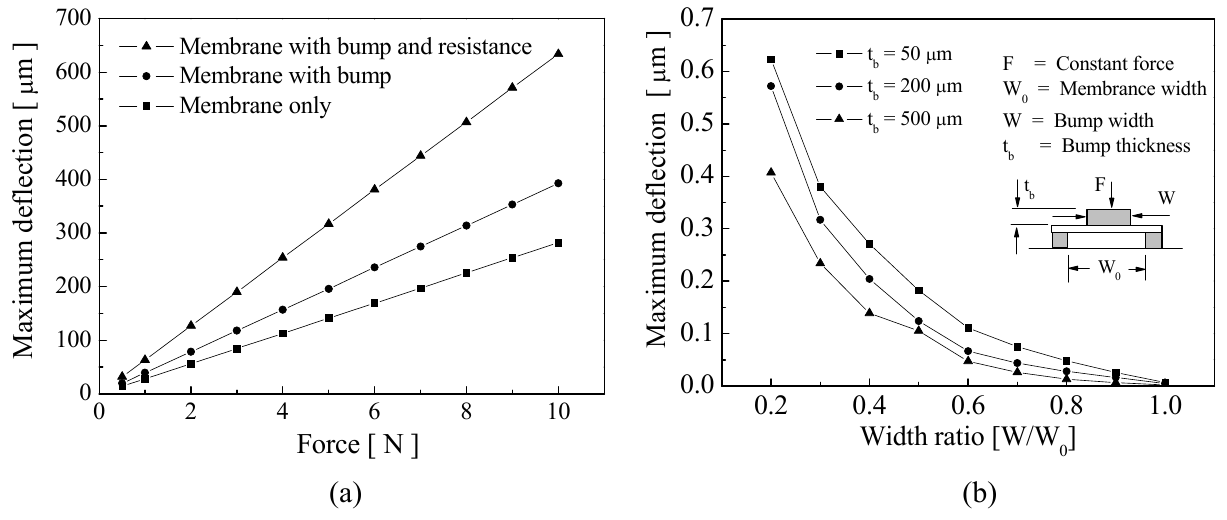
Figure 4. Comparison of the structural characteristics. (a) The effects of membranes without bumps, with bumps, and with bumps and a resistance layer, and (b) the effects of bump widths and thicknesses of 100, 250, and 500 μ